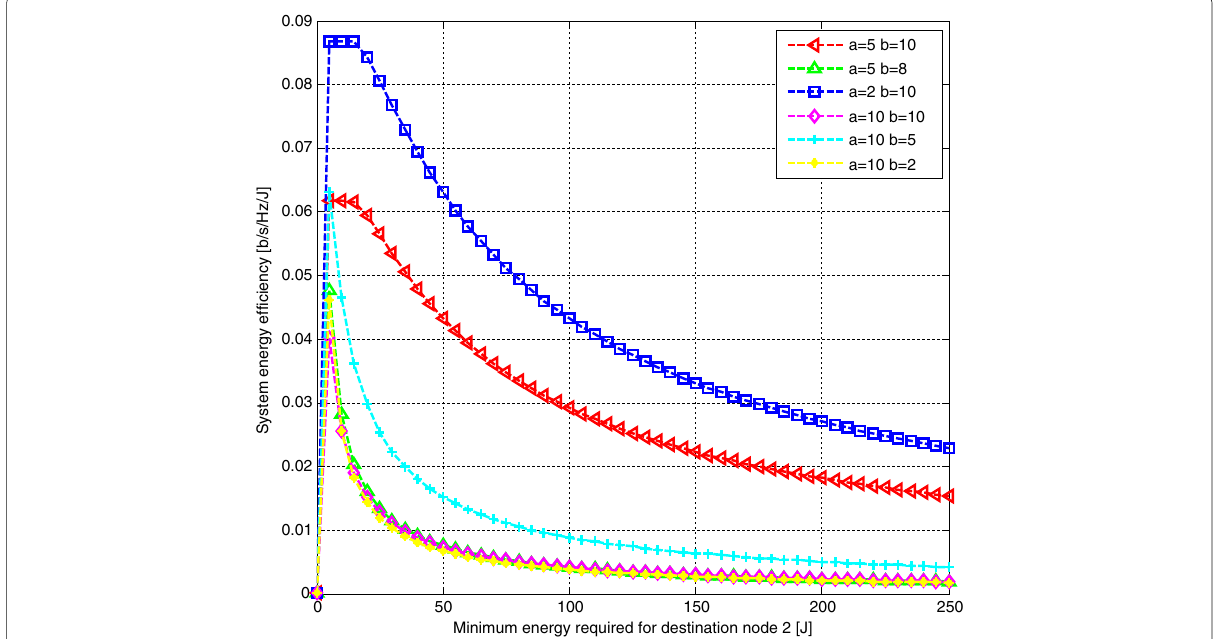
Fig. 3 Achieved energy efficiency of the whole IoT systems by the proposed scheme at the power splitting factor ρ = 0.1